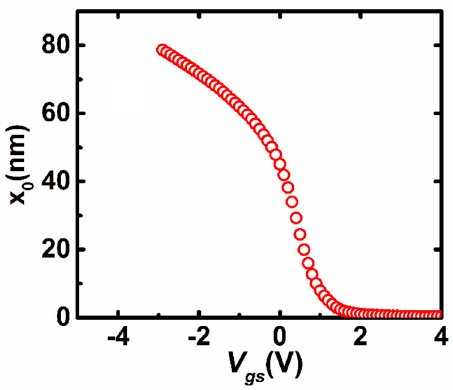
Figure 5. The calculated results of x 0 versus V gs .